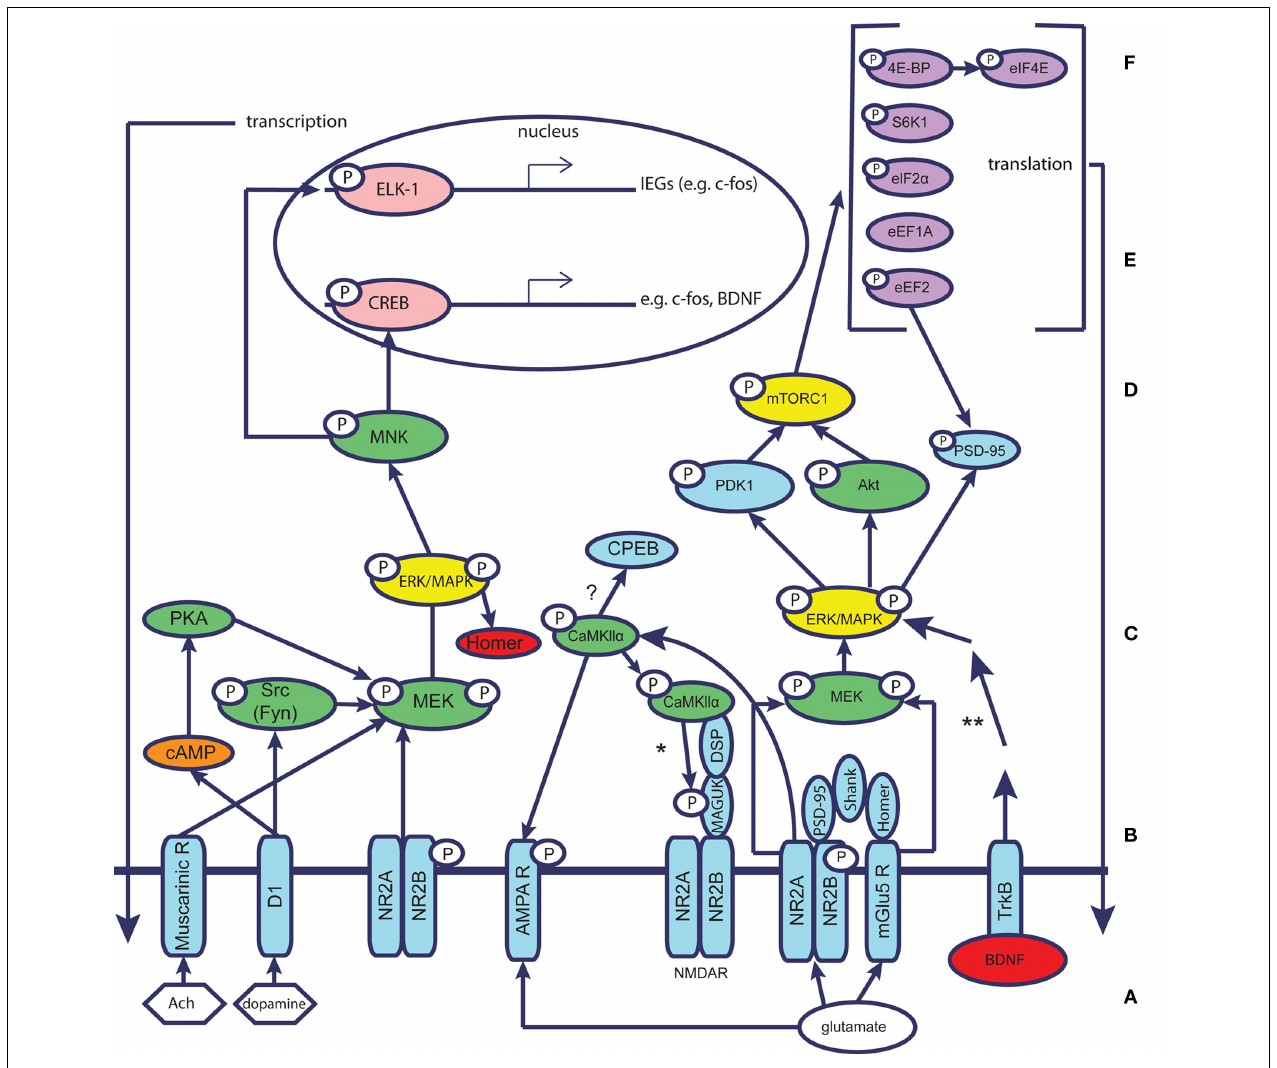
FIGURE 3 | Molecular mechanisms underlying taste learning in the gustatory cortex: schematic simplified representation assuming the different molecular events take place within the same neuron. Glutamate/neuromodulators (Ach, dopamine) reach the postsynaptic site and affect the neuron through specific receptors (NMDAR, AMPAR, mGluR, muscarinic receptors, dopamine receptors, e.g., D1).The receptors are linked to scaffold proteins that form the postsynaptic density (PSD), e.g., MAGUKs, Shank, Homer. MAGUKs are linked through distal scaffolding proteins (DSP) to CamKII.The complexes of receptors and PSD proteins activate signal transduction and hub molecules, which in turn activate transcription and translation regulation.This chain of events, according to our current understanding, results in a new cellular steady state. It is currently unknown whether all molecular processes depicted occur within a single neuron – a question that remains to be